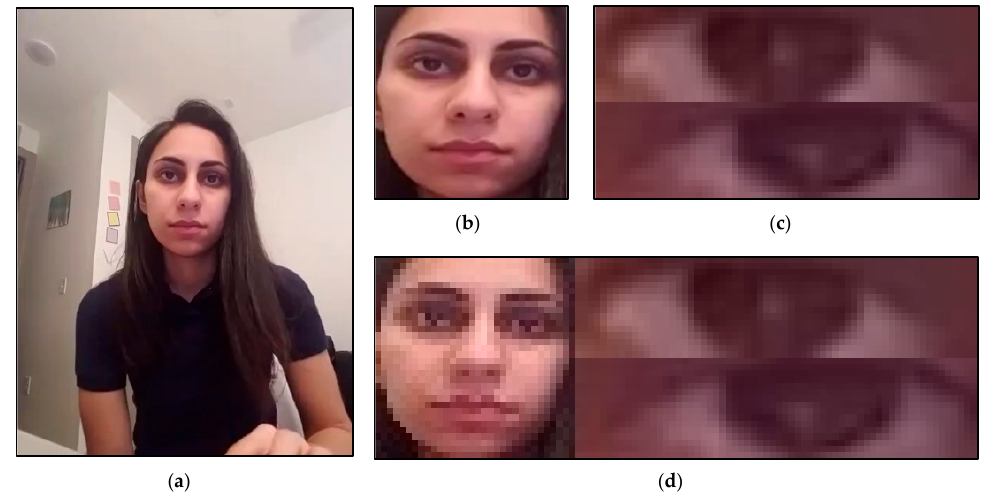
Figure 2. The pre-processed results for the neural network input: ( a ) origin input, ( b ) face extraction result, ( c ) eye extraction result, and ( d ) fusion result. (The ID number of the participants is seventeen in the UTA-RLDD. The participant claims to allow her image to be published in research papers and publications.).